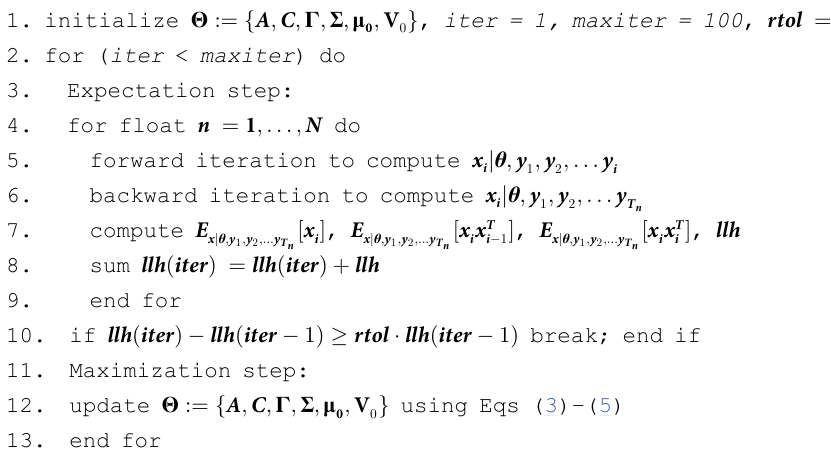
Algorithm 2. Training the vLDS model on the cross-validation dataset with many